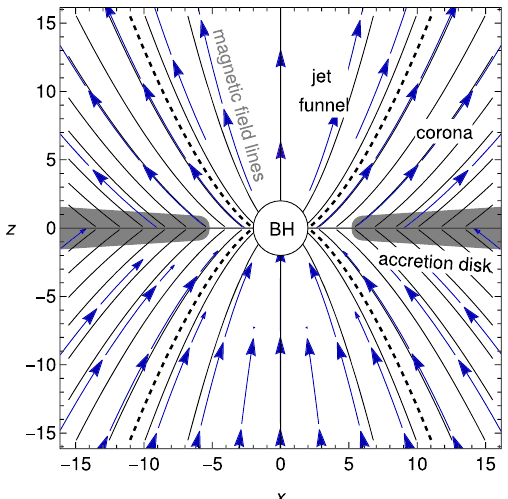
Fig. 1 Parabolic MF configuration around Schwarzschild BH. Quasi neutral Keplerian accretion disk formed by particles on circular orbits close to the equatorial plane is restricted in its inner edge by the equa- torial innermost stable circular orbit (inISCO). The dashed curve is the boundary between the accretion disk corona and jet funnel region close to the z